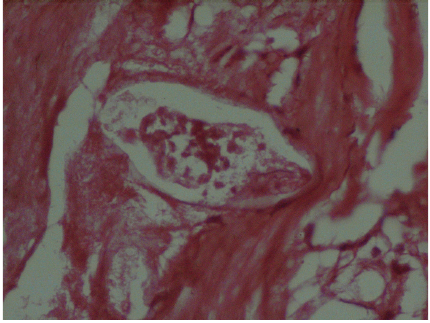
Figure 2: Right fallopian tube showing schistosoma ova in the